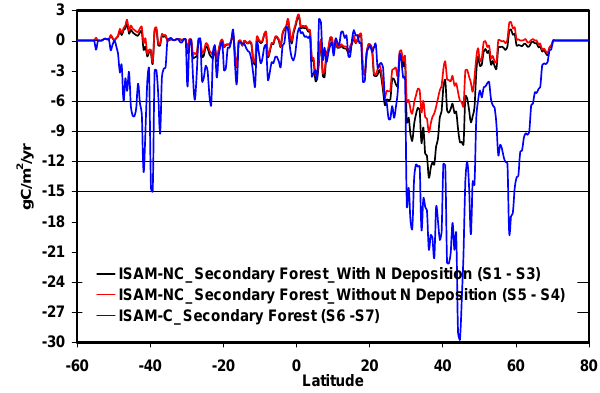
Figure 4. Global net carbon flux (GtC/a) in secondary forests comparing ISAM-NC Fig. 4. Global net carbon flux (GtC/a) in secondary forests compar- including N deposition(S1 minus S3) and ISAM-NC-without N deposition(S5 minus S4) ing ISAM-NC including N deposition (S1 minus S3) and ISAM- between 1900 and 2000. Positive values represent net C release to the atmosphere and NC-without N deposition (S5 minus S4) between 1900 and 2000. negative values represent net C storage in terrestrial biosphere. Positive values represent net C release to the atmosphere and nega- tive values represent net C storage in terrestrial biosphere.